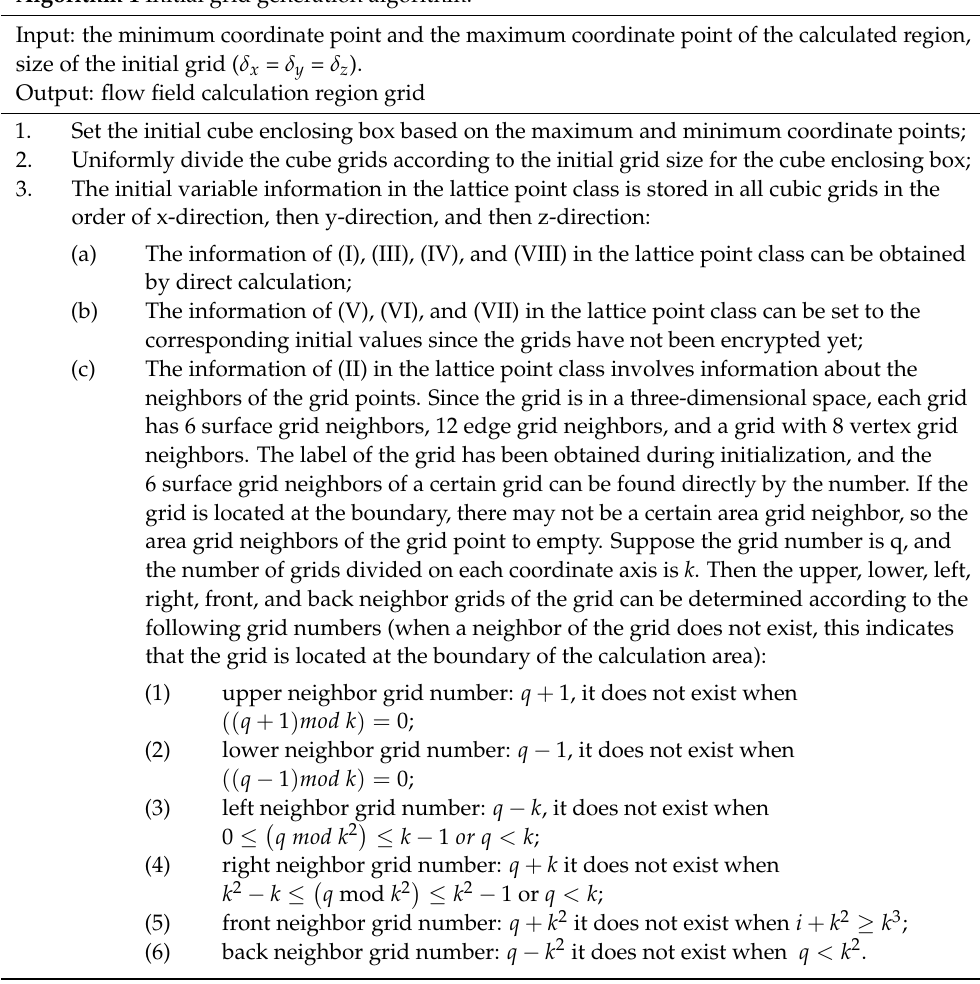
Algorithm 1 Initial grid generation